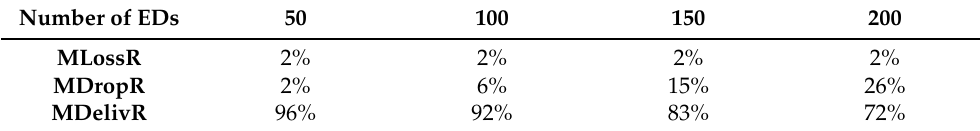
Table 6. Average values of MLossR, MDropR and MDelivR varying the number of EDs. Number of